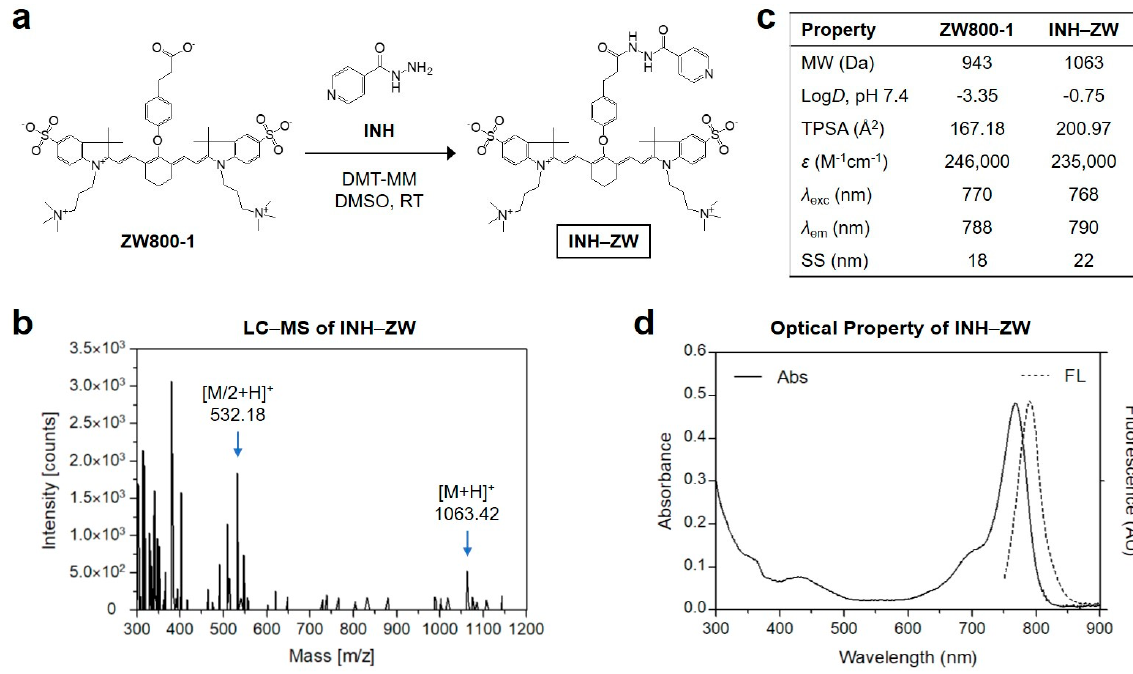
Figure 2. ( a ) Synthesis scheme; ( b ) mass spectrum; ( c ) physicochemical and optical properties; ( d ) absorbance and fluorescence emission spectra of the INH–ZW conjugate. Optical measurements were performed in PBS at pH 7.4. In silico calculations of log D at pH 7.4 and the topological polar surface area (TPSA) were performed using the Marvin and JChem calculator plugins (ChemAxon, Budapest, Hungary).